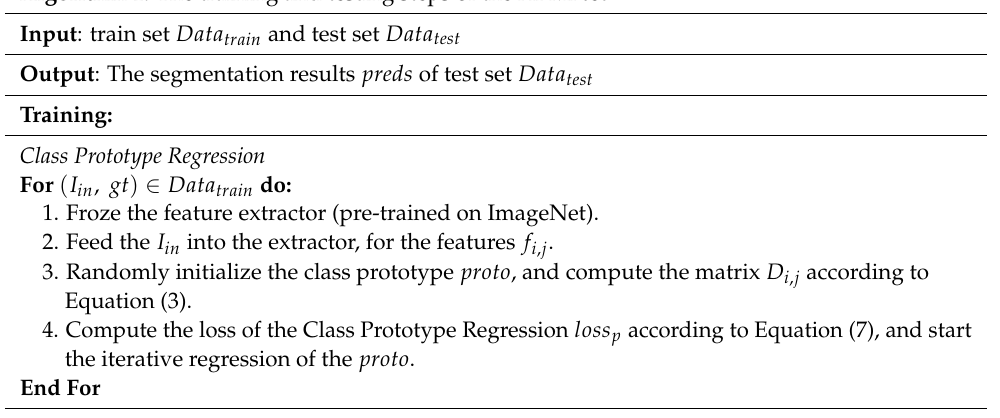
Algorithm 1: The training and testing steps of the